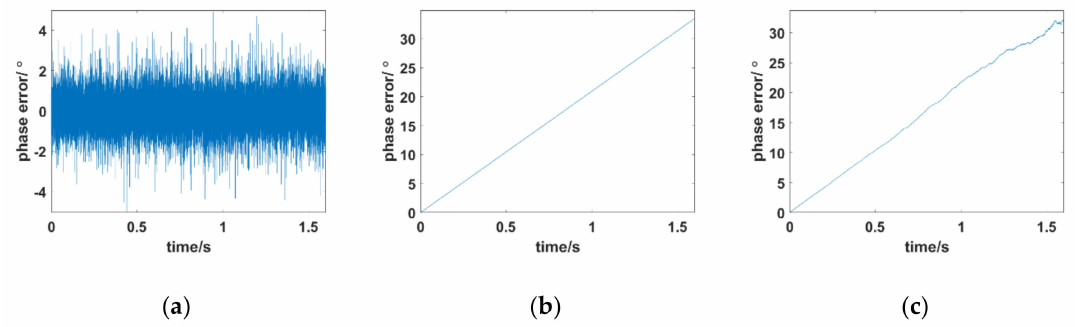
Figure 5. Phase error between the received signal and local carrier of the designed Kalman tracking loop at 30 km. ( a ) Ka band = 30 GHz; ( b ) C band = 5.8 GHz; ( c ) S band =2.3